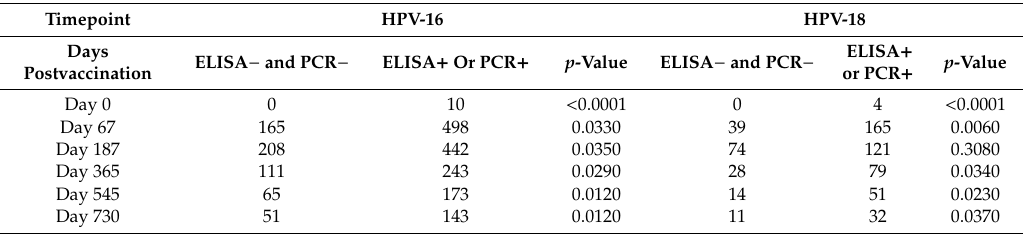
Table 2. Comparison of antibody responses in the HPV-exposed group with HPV-naïve in the prospective cohort.